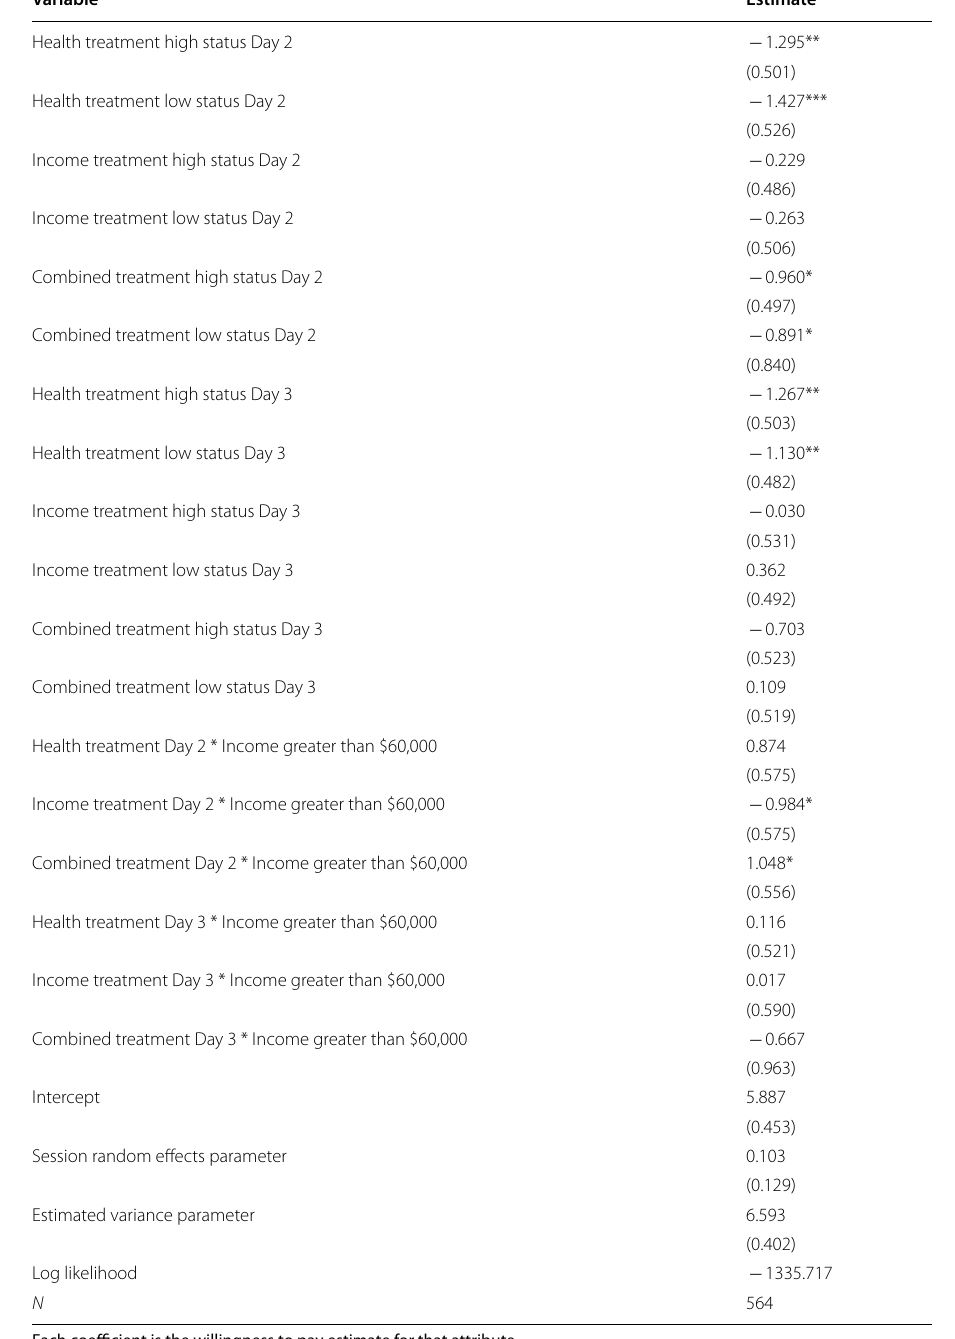
Table 4 Interactions of treatment status with income